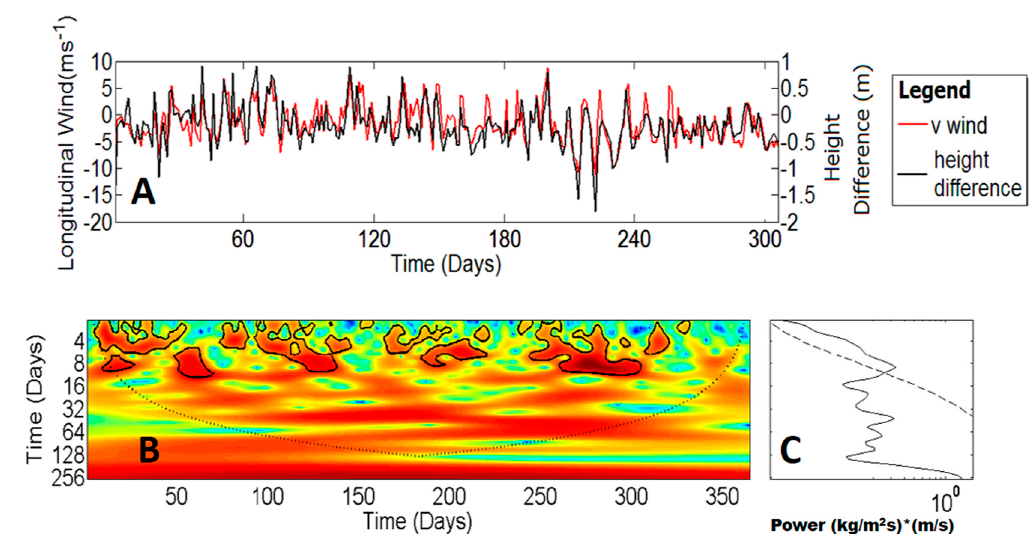
Figure 7. ( A ) Temporal variability of simulated height di ff erence between the Mirim lagoon extremities